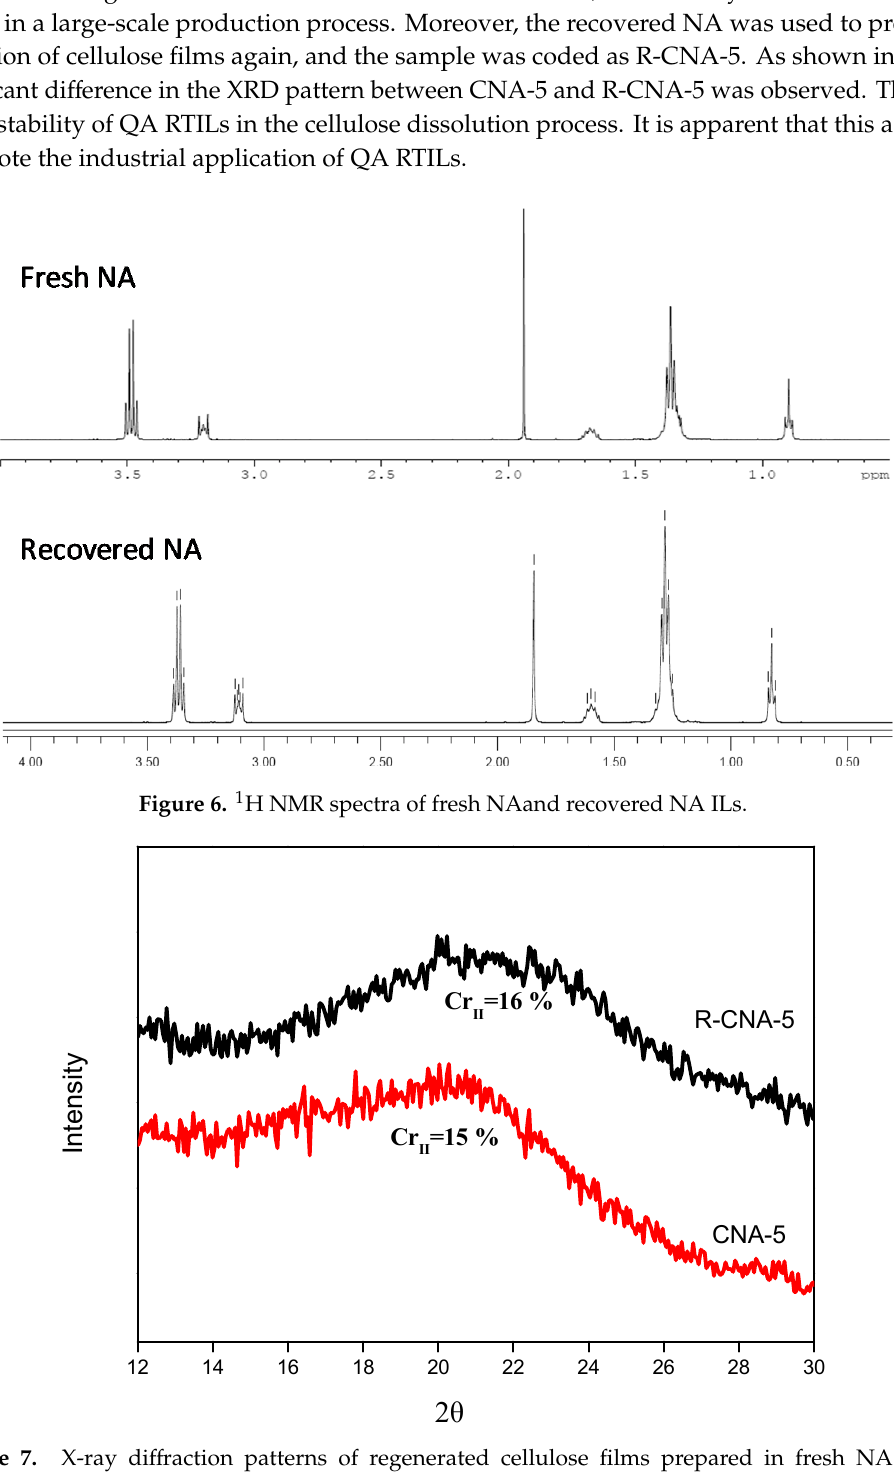
Figure 7. X-ray diffraction patterns of regenerated cellulose films prepared in fresh NA and recovered NA.